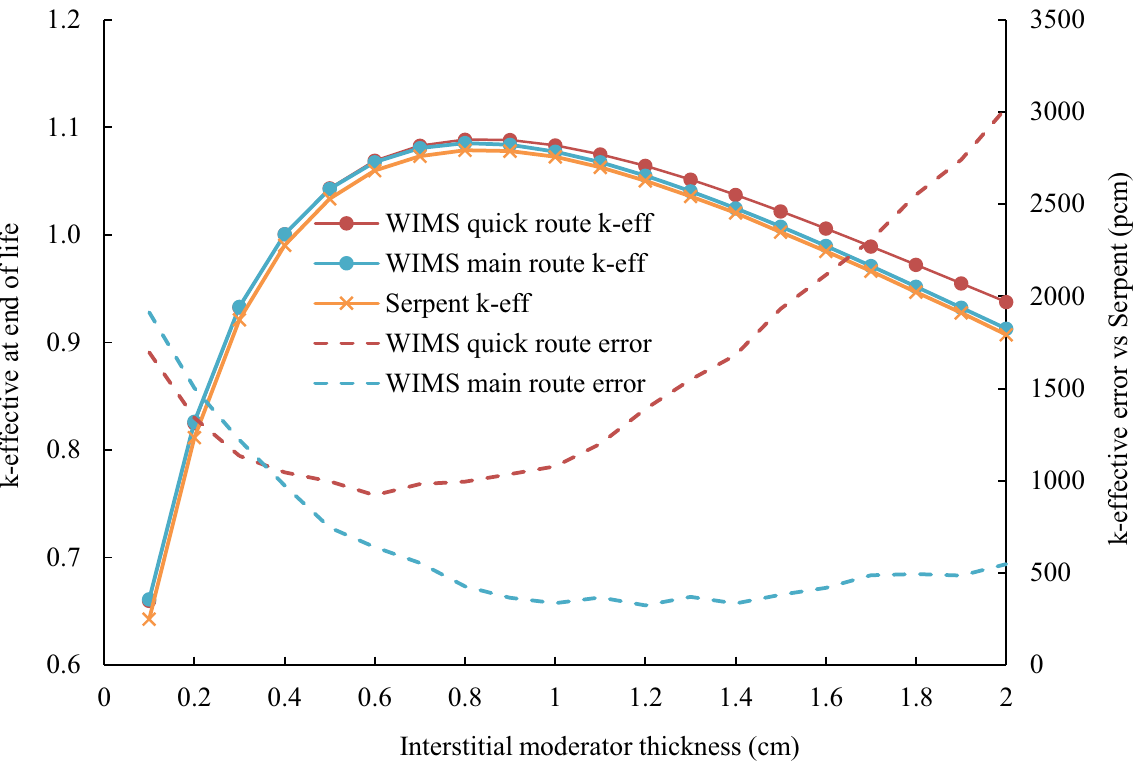
Figure 4: k-effective calculated at end of life for the two WIMS routes compared to Serpent with differing amounts of